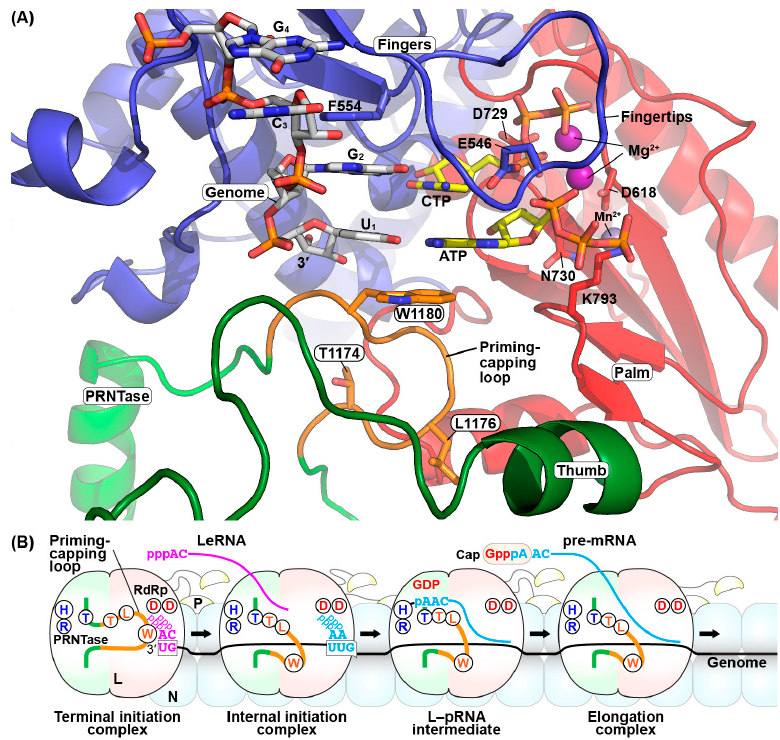
Figure 7. The roles of the GDP polyribonucleotidyltransferase (PRNTase) domain of the rabies virus (RABV) large (L) protein in transcription initiation and pre-mRNA capping. ( A ) The structure of an RABV terminal de novo initiation complex with a model RNA template (3 ′ -UGCG-5 ′ , white carbon backbone), initiator and incoming nucleotides (ATP and CTP, respectively; yellow carbon backbone), and divalent metal ions (Mg 2+ , purple; Mn 2+ , obscured) was modeled from the vesicular stomatitis virus initiation complex (Molecular Archive id: ma-5k432) based on the structure in [21]. The RNA- dependent RNA polymerase (RdRp) subdomains and PRNTase/priming loop of the RABV L protein are colored as in Figure 4. Key amino acid residues are shown as stick models. The coordinates of the modeled RABV terminal de novo initiation complex have been uploaded to the Model Archive (id: ma-uqibu). ( B ) A model for de novo transcription initiation and pre-mRNA capping by the RABV L protein is schematically presented. Only the PRNTase (pale green) and RdRp (pale red) domains of the L protein are depicted with the priming-capping loop (orange). Circled capital letters indicate the following amino acid residues: “T”, “H”, and “R” in the PRNTase domain are T1170, H1241, and R1242, respectively; “T”, “L”, and “W” on the priming-capping loop are T1174, L1176, and W1180, respectively; left and right "D"s in the RdRp domain are D618 and D729, respectively. The 3 ′ -terminal UG sequence of the Le ( − ) promoter and the internal UUG sequence of the N gene-start sequence are shown on the genome (black thick line). pppA and pppC indicate ATP and CTP, respectively. The nucleocapsid (N) and phospho- (P) proteins are shown in pale blue and pale yellow, respectively.